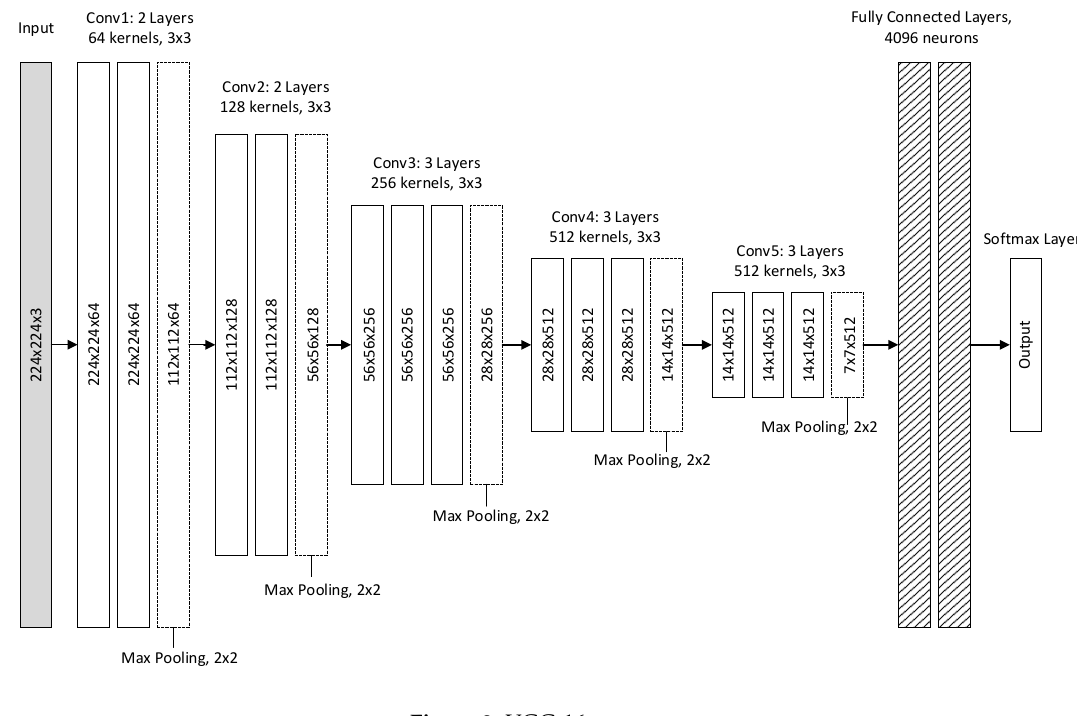
Figure 2. VGG-16